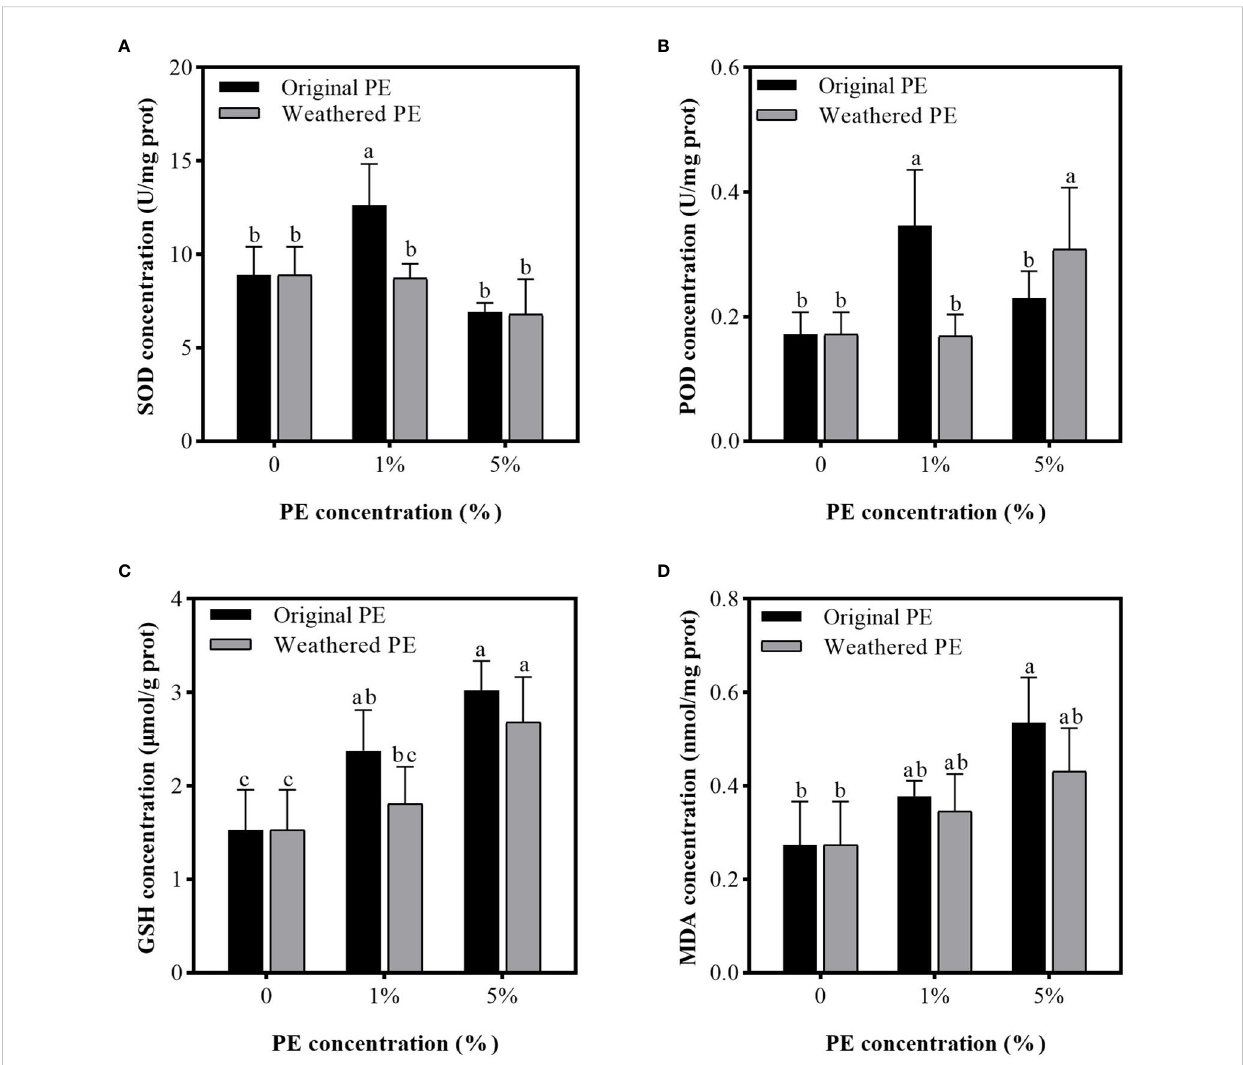
FIGURE 5 SOD (A) , POD (B) , GSH (C) , and MDA (D) concentrations in the leaves of sweet potatoes planting in PE MPs and Cd compound-contaminated soil. Plant samples are collected after been treated by original or weathered PE MPs (0, 1% and 5%) for 15 days. Different letters in each fi gure indicate signi fi cant (p < 0.05) differences according to Tukey ’ s